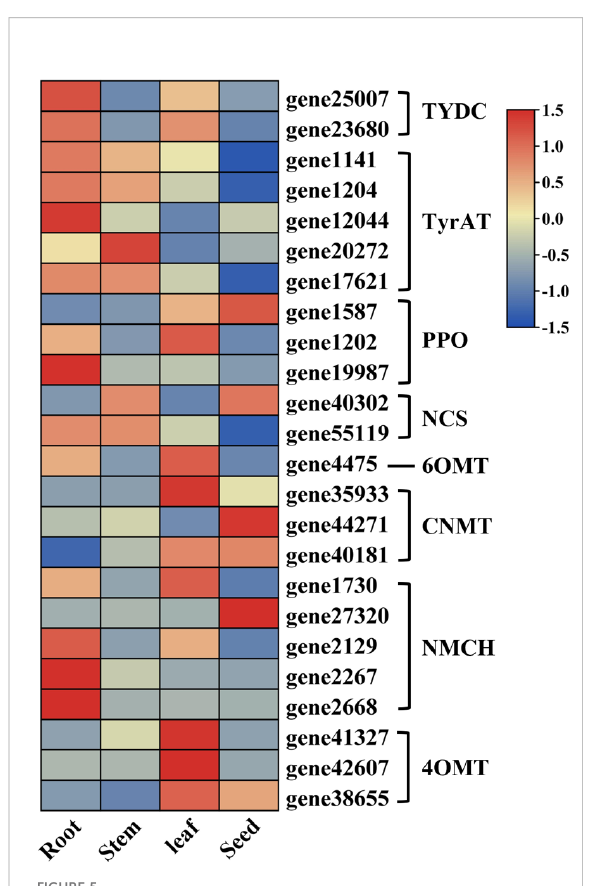
FIGURE 5 Expression patterns of candidate unigenes in the common biosynthetic pathway of